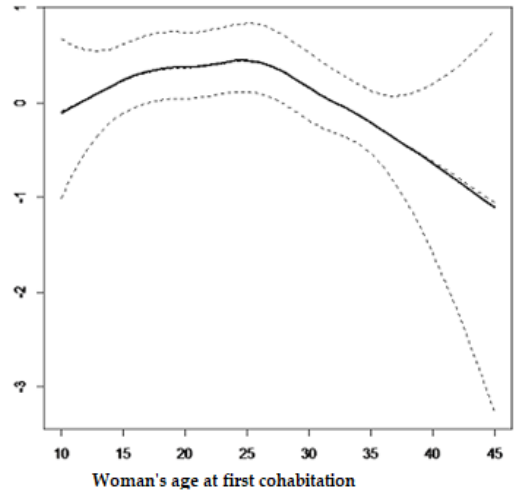
Figure 2. Effects of woman’s age at first cohabitation .